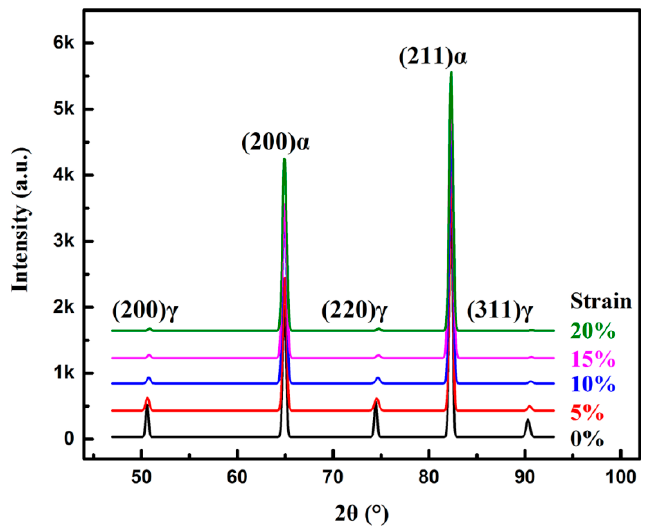
Figure 6. X-ray diffraction spectra of the specimens at different strain levels ranging from 0% to 20% in the strain rate of 0.001 s − 1 .